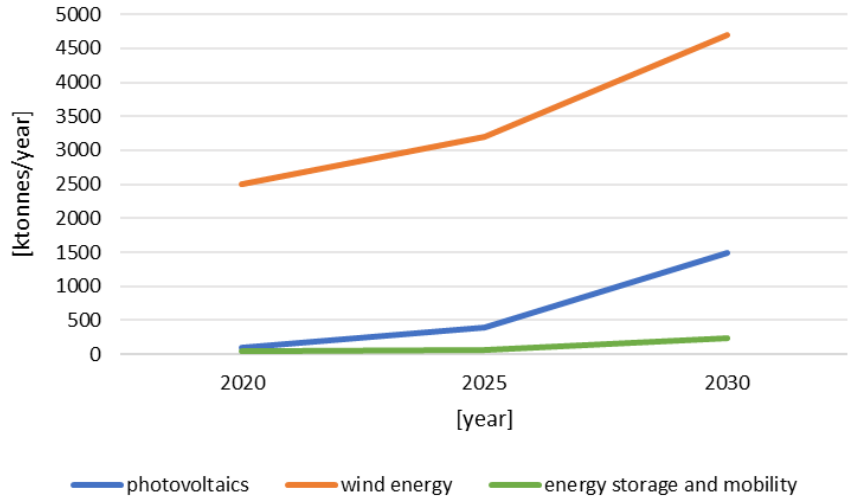
Figure 2. Growth of waste materials from renewable resources.